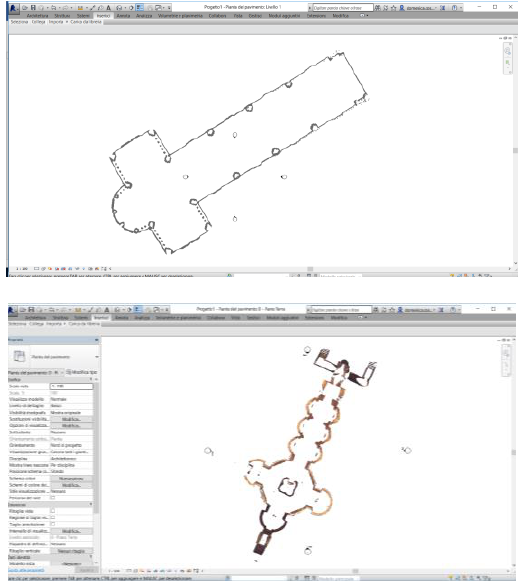
Figure 17. Upper Basilica (up) and Crypt (down) point clouds represented in Revit 2D